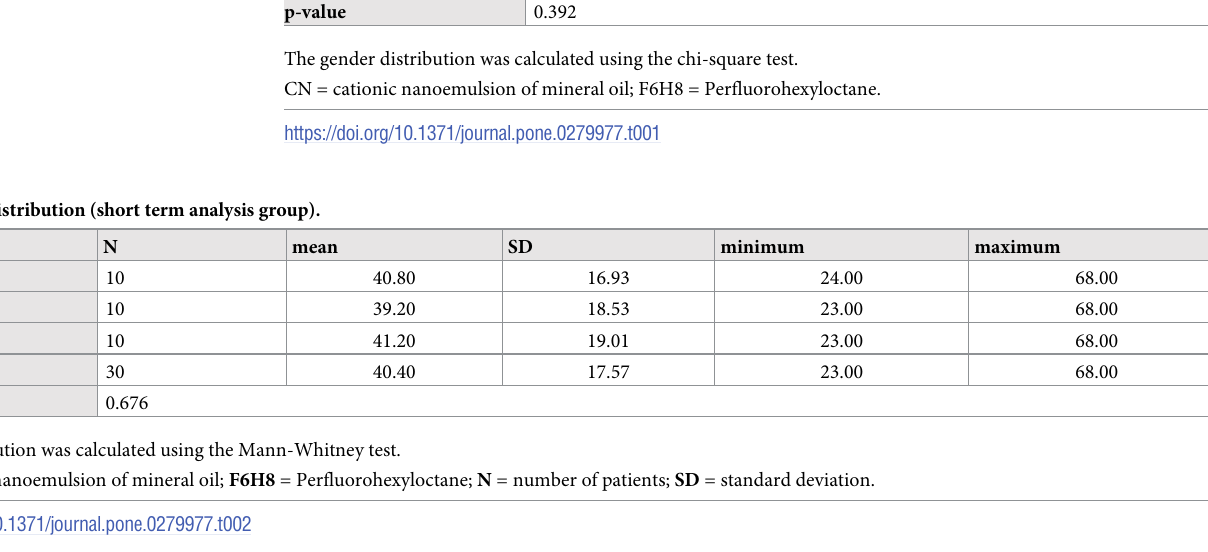
The gender distribution was calculated using the chi-square test.